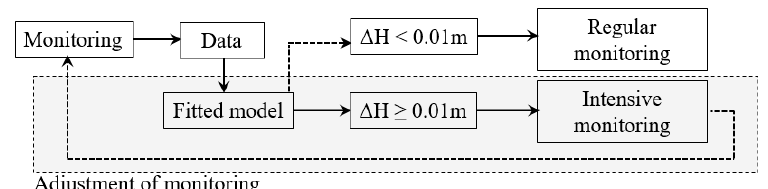
Figure 11. The decision algorithm for monitoring adjustment.